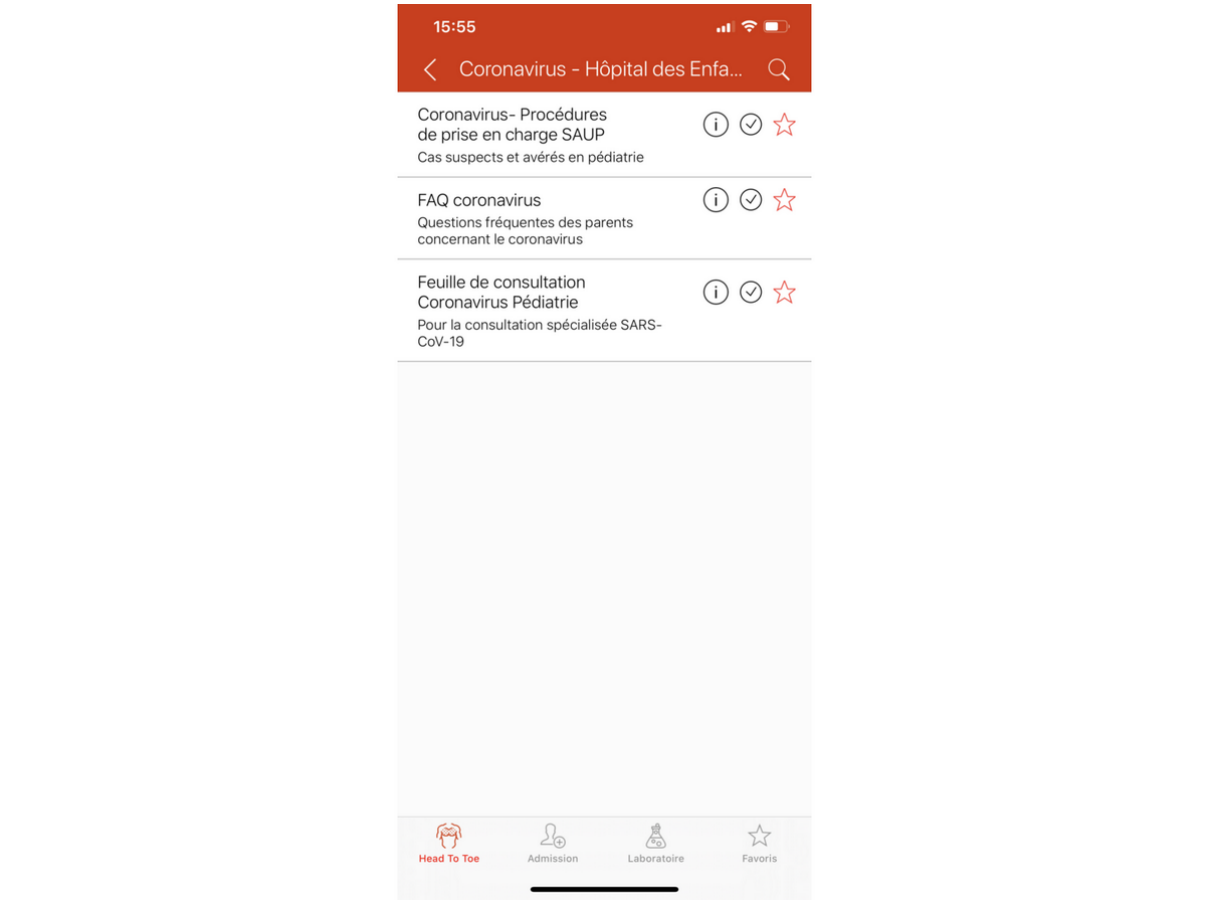
Figure 1. Mobile app user interface displaying the documents section with COVID-19